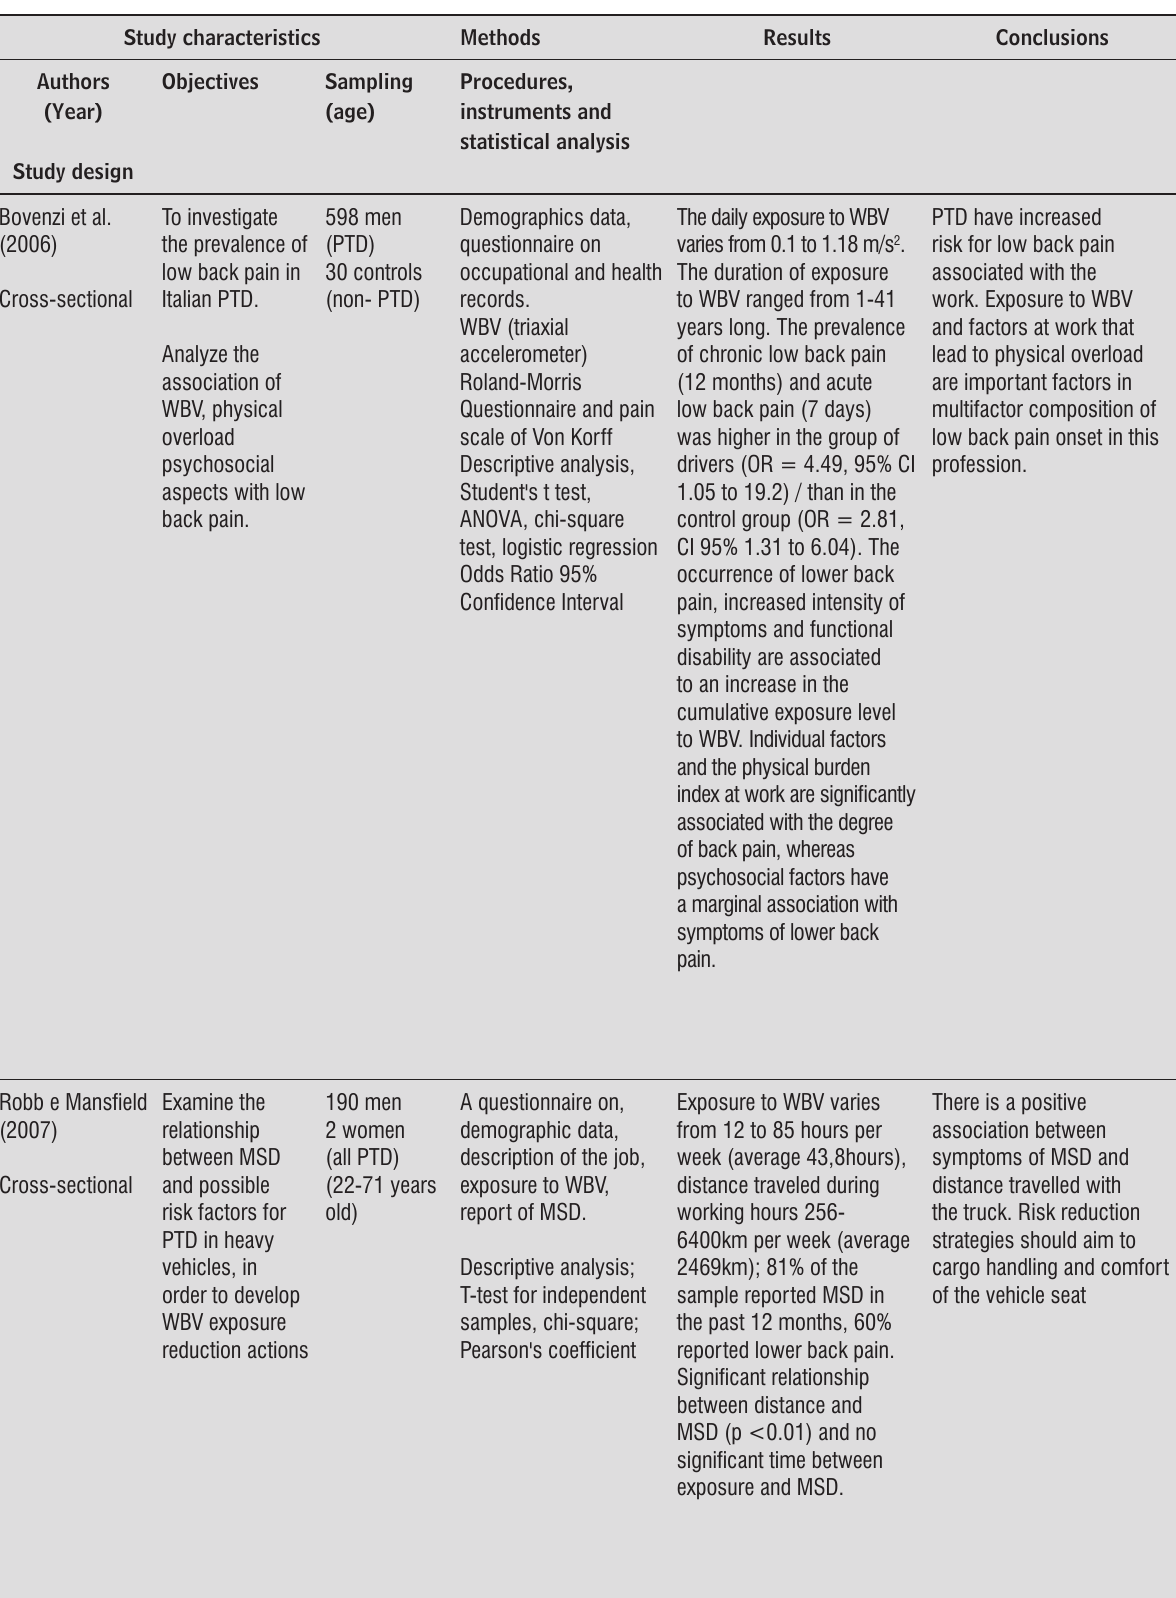
Table 3 - Characteristics of the articles selected for systematic